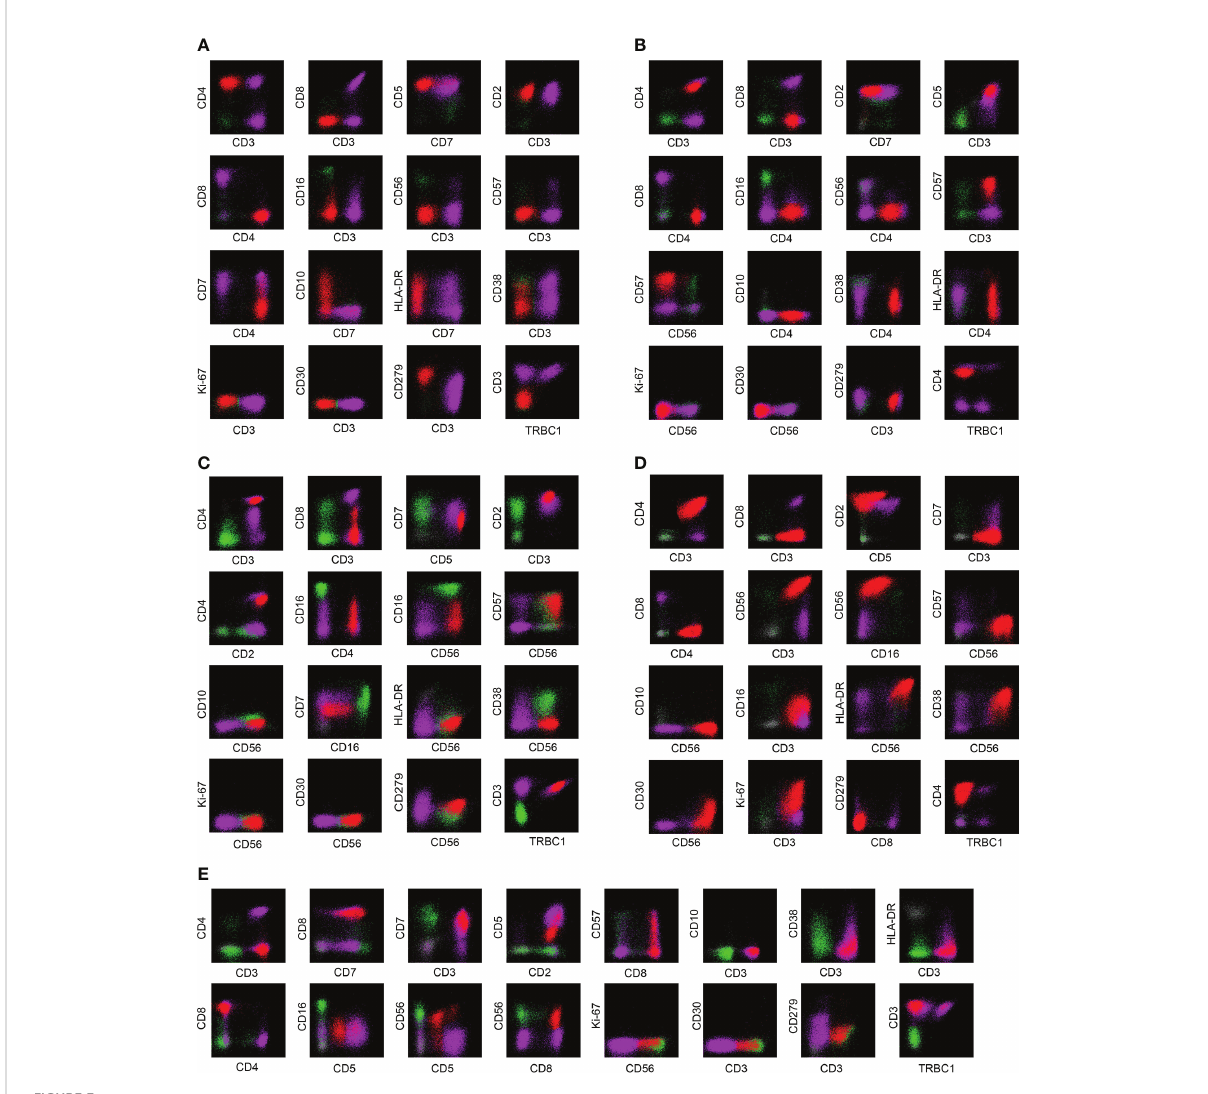
FIGURE 3 Examples of immunophenotypes for AITL, PTCL-NOS, ENKTL-N, ALCL, and T-CUS. (A) Typical FCM immunophenotype of AITL: CD3(-)CD4(+) CD10(+)PD-1(+); (B) Typical FCM immunophenotype of PTCL-NOS: CD2(+)CD4(+) CD7(-); (C) Typical FCM immunophenotype of ENKTL-N: CD3(+)CD56(+); (D) Typical FCM immunophenotype of ALCL: CD30(+)Ki-67(+); (E) Typical immunophenotype of T-CUS: CD3(+)CD8(+). The red dots in the fi gure are clonal T cells, the purple dots are background normal T cells, and the green dots are NK cells as an internal